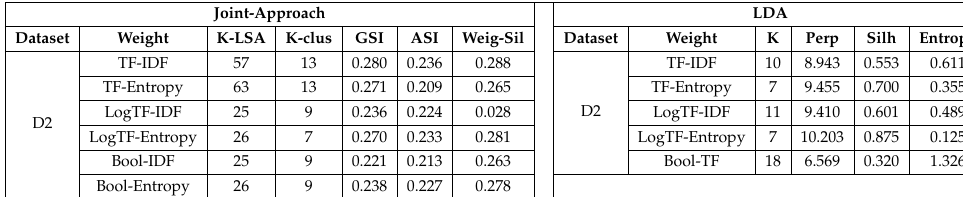
Table 6. Experimental results for D2.